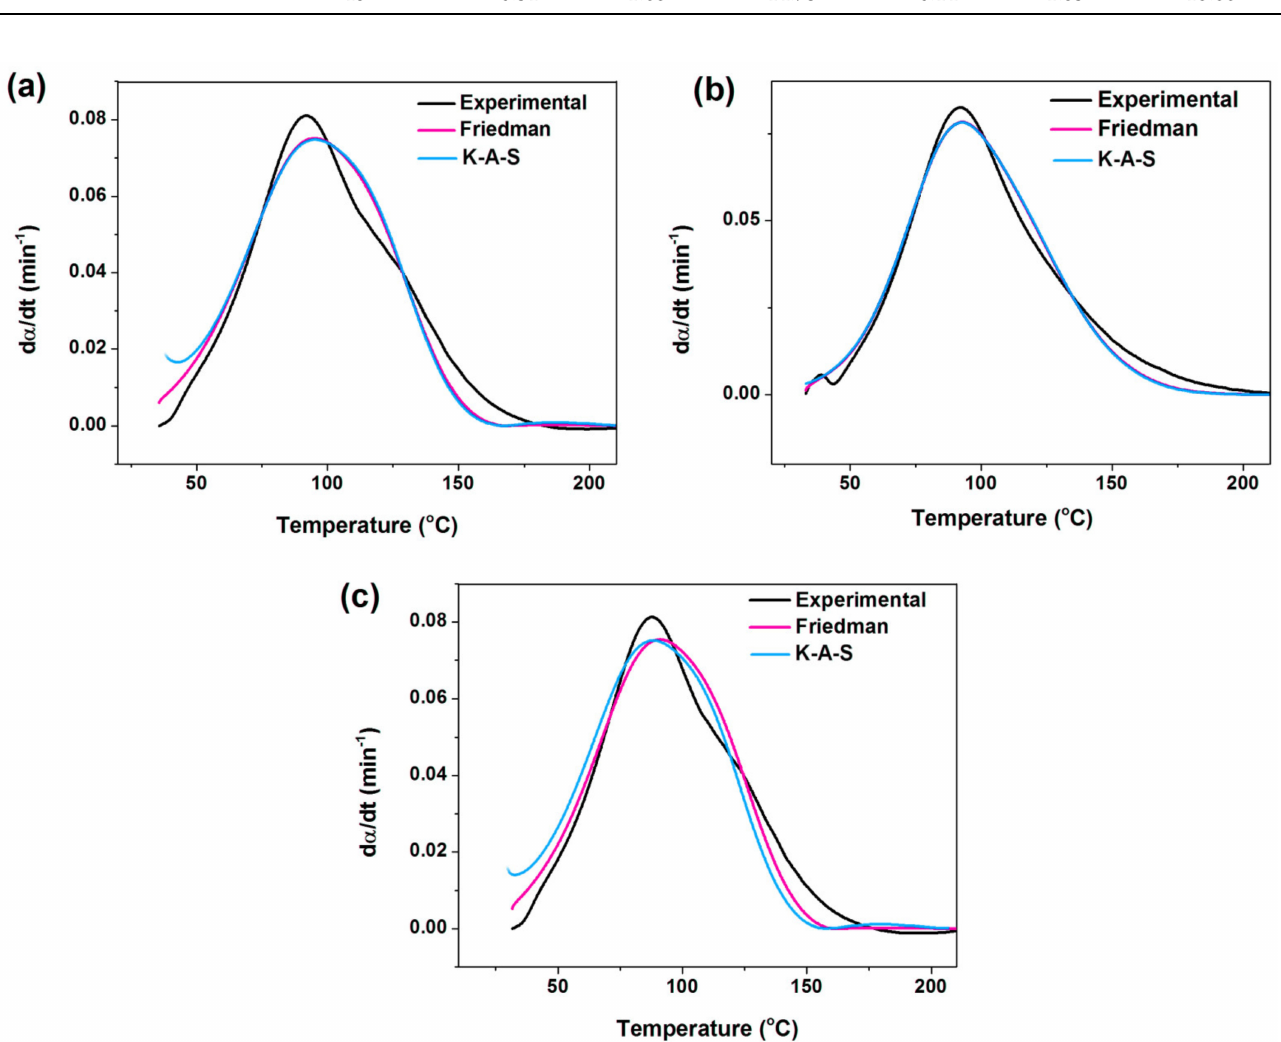
Figure 10. Typical of comparison between experimental and isoconversional approaches at heating rate of 5 ◦ C min − 1 for EP ( a ), EP/Mica ( b ), and EP/Mica-IM ( c )